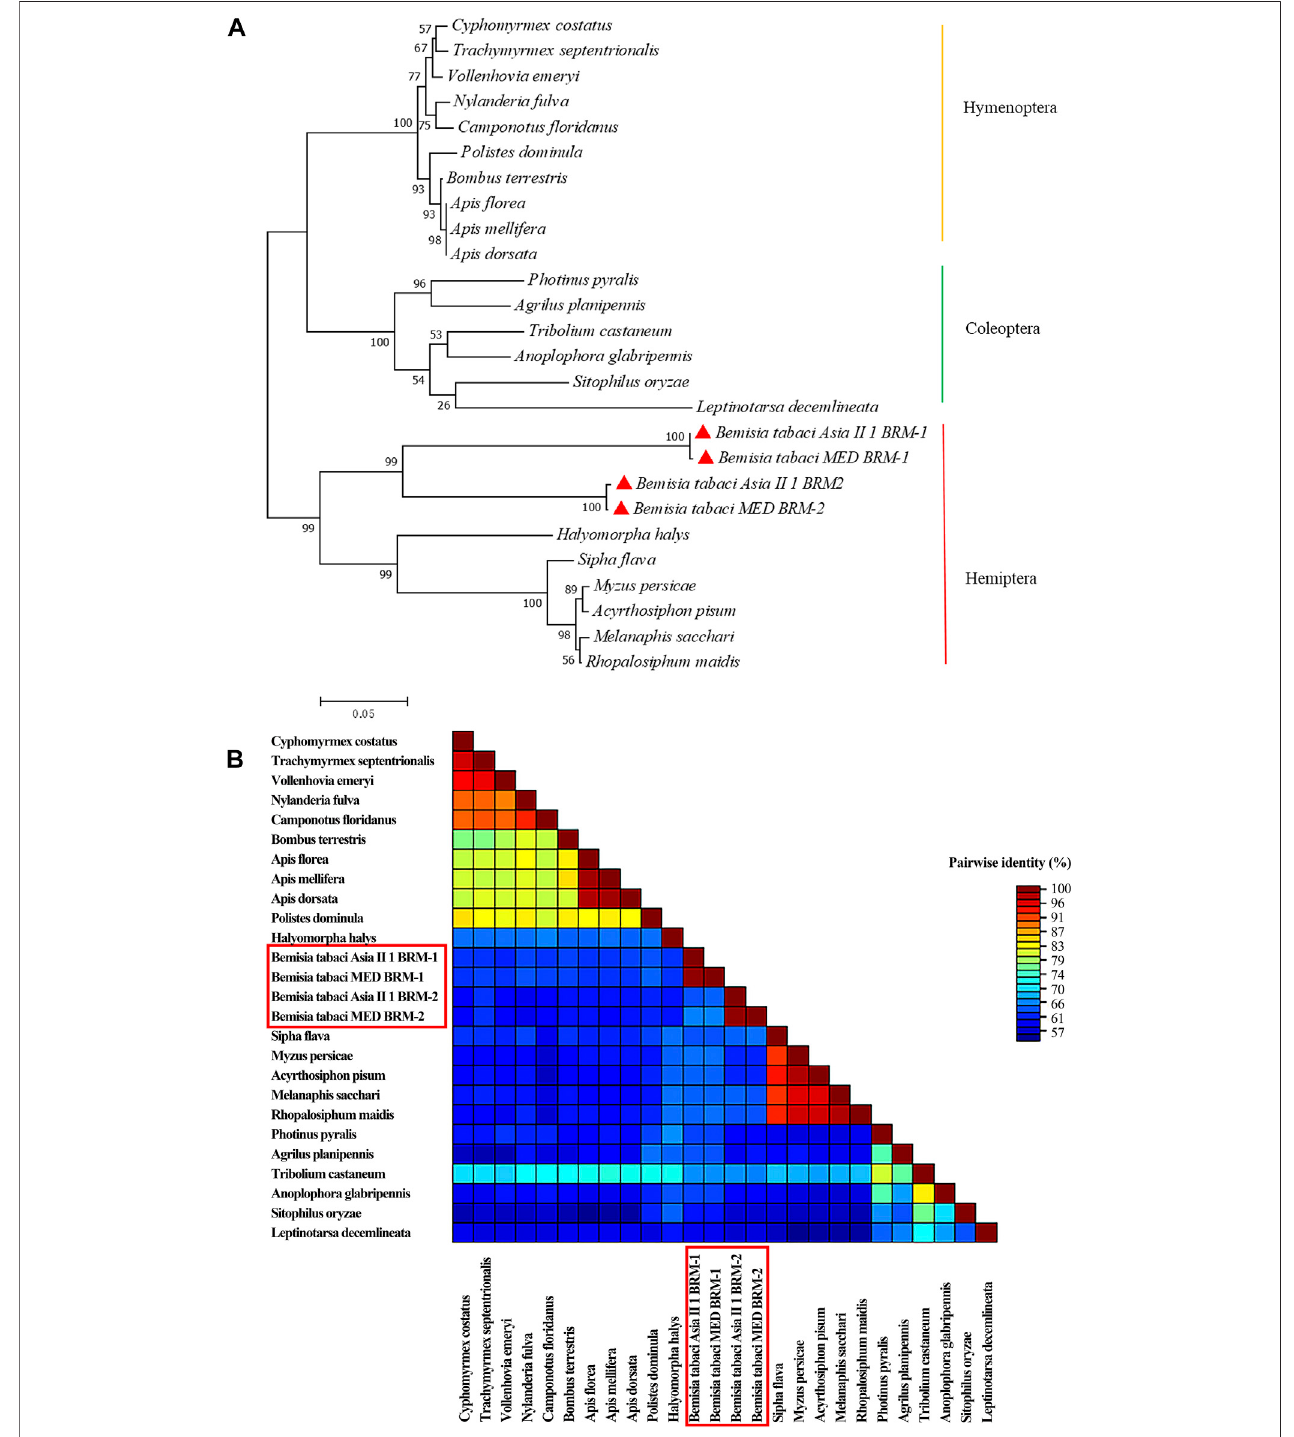
FIGURE 4 | The relationships of Bt-BRM-1, Bt-BRM-2 and the homologous sequences from other species. (A) Phylogenetic analysis of the homologous sequences from various species performed using the maximum likelihood method based on the Whelan Goldman (WAG) model with 1,000 bootstrap replications. Bt- BRM-1 and Bt-BRM-2 are highlighted with red triangles, and the protein sequences which used for phylogenetic analysis are listed in Supplementary Table S2 . (B) Color-codedpairwiseidentitymatrixfromaminoacidsequencesofremodelersfromdifferentspeciesgeneratedusingSDTsoftware.Bt-BRM-1andBt-BRM-2are marked with red